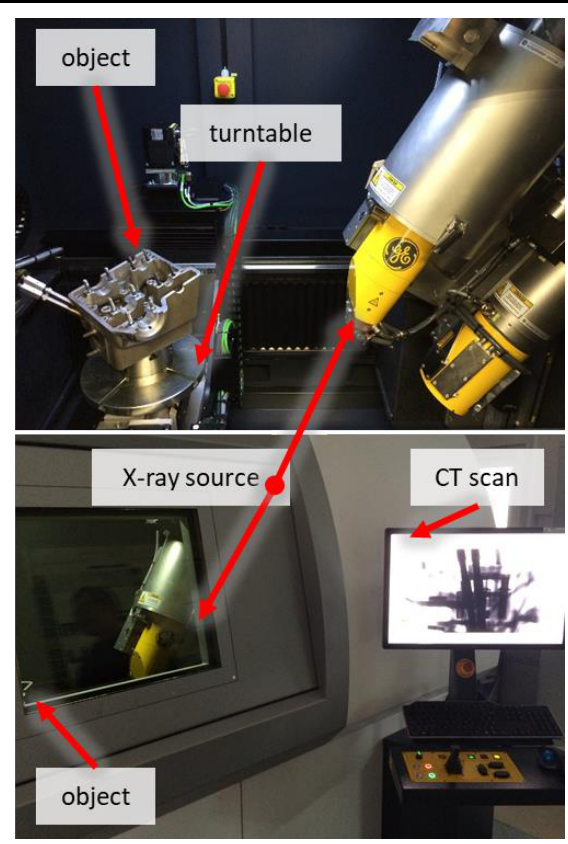
Fig. 10. Location of the research engine head in a GE tomographic scanner model V/Tome/x m The range of Hounsfield units for CT is –1000 to +4000, and it allows the image to be represented in shades of grey. Only 256 gray levels are used in practice, which is a selected slice of the CT number value. It makes it possible to observe the image with high contrast, thus enabling the interpretation of the measurement result (Fig. 11).